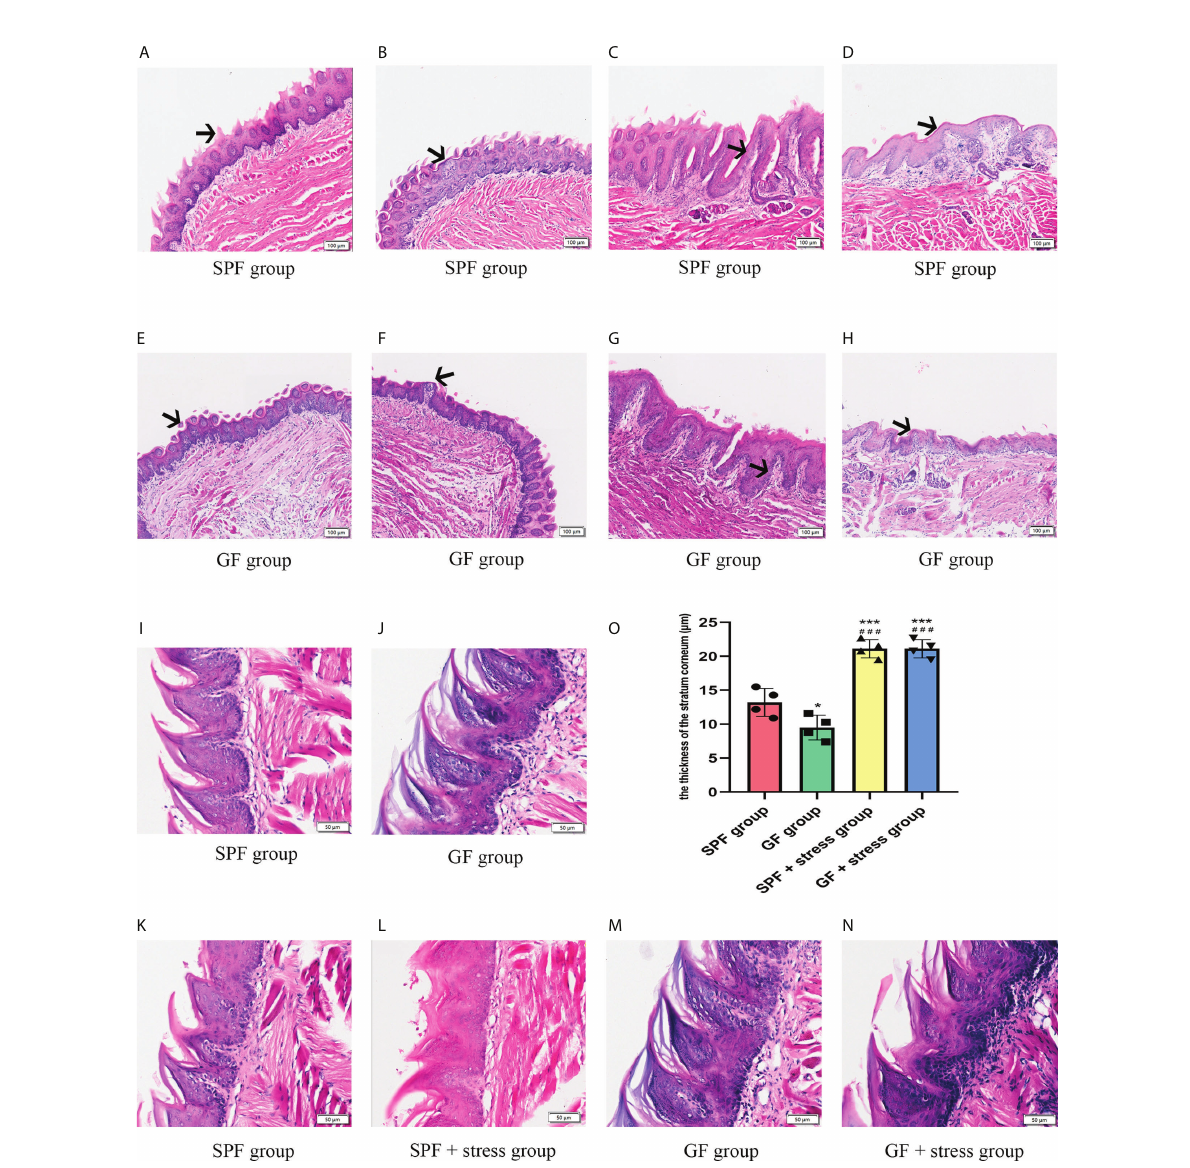
FIGURE 2 Microbiota regulates the morphological structure of the lingual epithelium. (A, B) HE staining of the anterior and middle regions of the lingual dorsum of SPF mice. The black arrows in Figures A and B represent the Fip and Fup on the lingual dorsum of SPF mice, respectively. (C, D) HE staining of the posterior region of the lingual dorsum in SPF mice. The black arrows in Figures C and D represent the Fop and Cip on the lingual dorsum of SPF mice, respectively. (E, F) HE staining of the anterior and middle regions of the lingual dorsum of GF mice. The black arrows in Figures E and F represent the Fip and Fup on the lingual dorsum of GF mice, respectively. (G, H) HE staining of the posterior region of the lingual dorsum in GF mice. The black arrows in Figures G and H represent the Fop and Cip on the lingual dorsum of GF mice, respectively. (I) The epithelial structure of Fip on the lingual dorsum of SPF mice. (J) The epithelial structure of Fip of the lingual dorsum of GF mice. (K) The morphological structure of tongue epithelium in SPF mice. (L) The morphological structure of tongue epithelium in SPF mice under chronic stress. (M) The morphological structure of tongue epithelium in GF mice. (N) The morphological structure of tongue epithelium in GF mice under chronic stress. (O) The bar graph of stratum corneum thickness of tongue epithelium in four groups of mice. Fip, fi liform papillae; Fup, fungiform papillae; Fop, foliate papillae; Cip, circumvallate papillae. Scale bar: 100 or 50 m m. The experiments were performed at least three times independently. *p < 0.05 vs SPF group; **p < 0.01 vs SPF group; ***p < 0.001 vs SPF group; #p <0.05 vs GF group; # #p < 0.01 vs GF group; # # #p < 0.001 vs GF